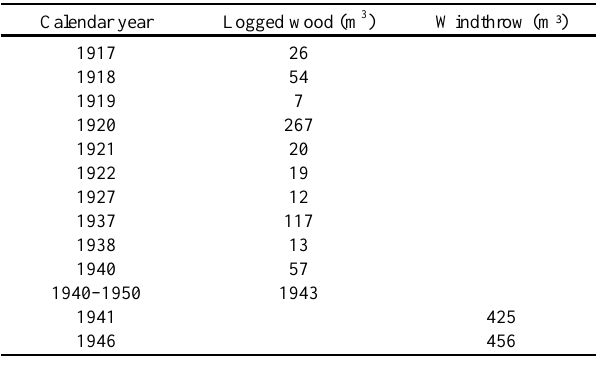
Table 2 . History of logging and windstorms in the pasture Rionde. Logging means cut off of standing trees and not exploitation of uprooted trees from windthrow. Especially during the Second World War, the wooded pastures were heavily exploited for fire wood. (Source: Forest Office, 14th